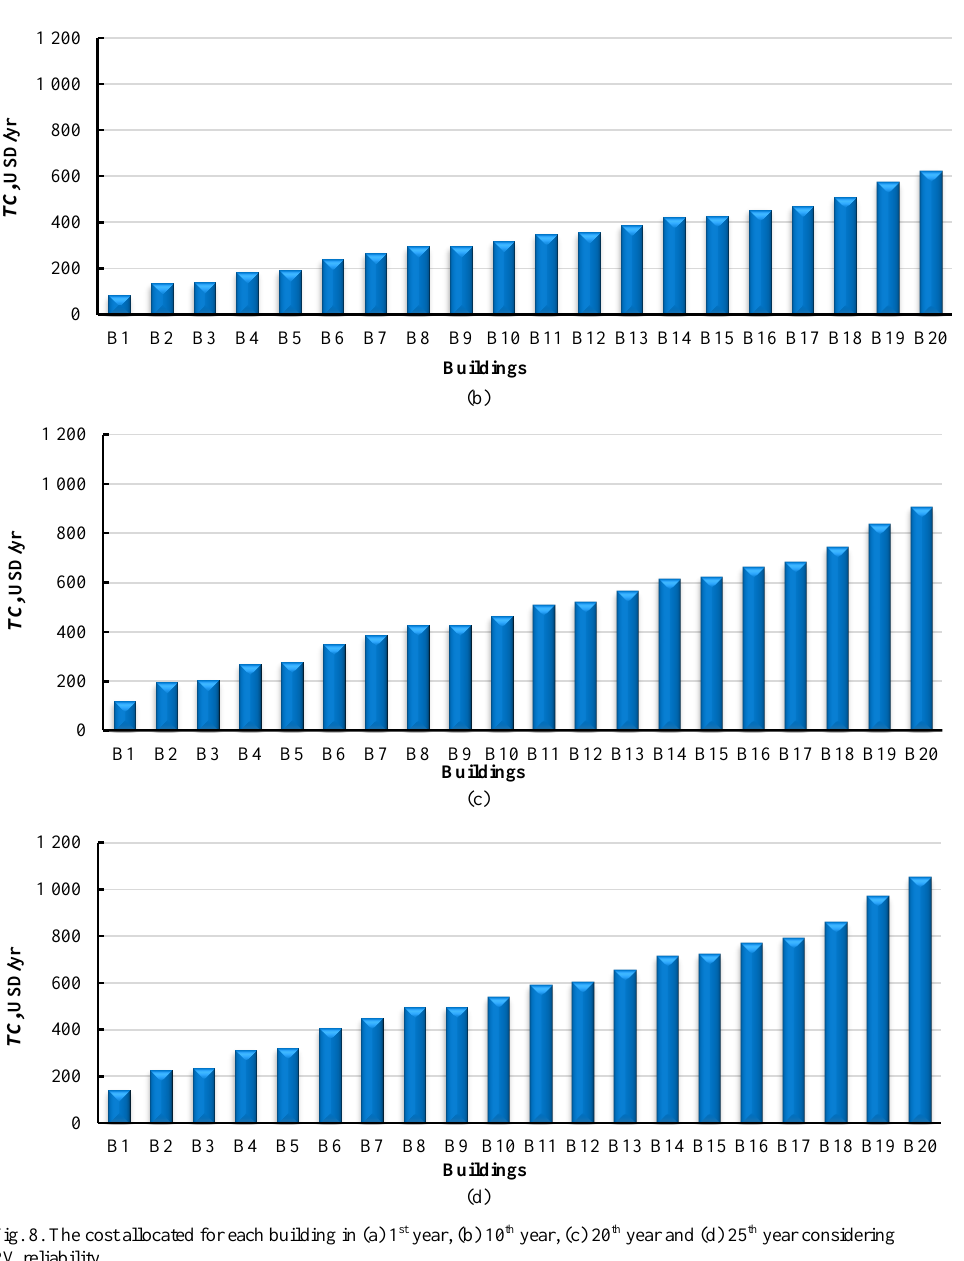
Fig. 8. The cost allocated for each building in (a) 1 st year, (b) 10 th year, (c) 20 th year and (d) 25 th year considering PV